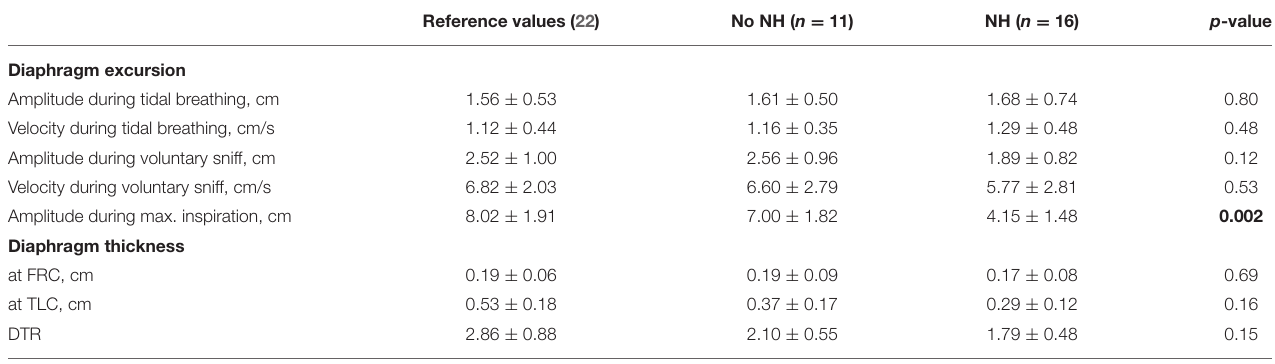
TABLE 3 | Diaphragm ultrasound parameters in patients with and without nocturnal hypoventilation. Reference values